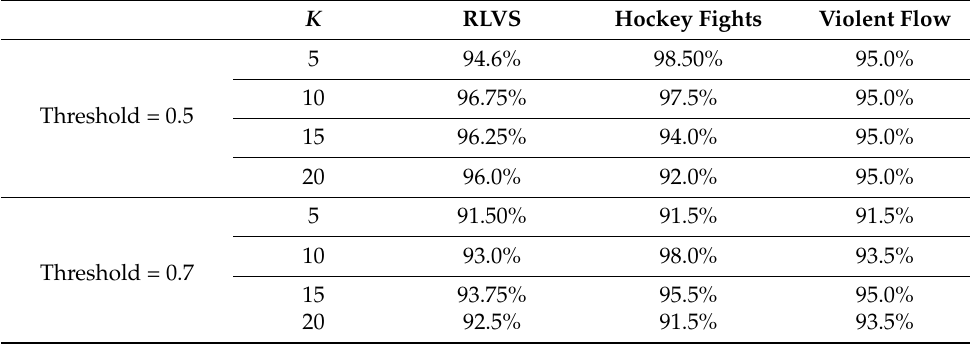
Table 8. The relationship between window length and recognition rate.